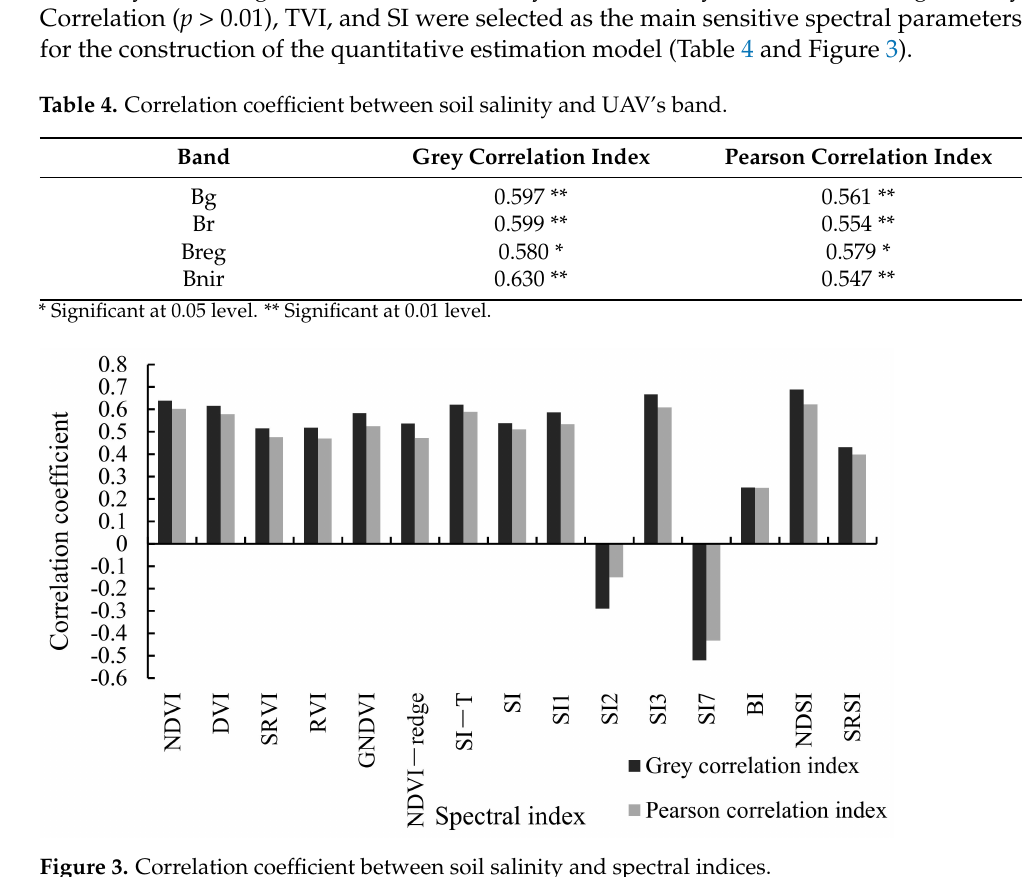
Figure 3. Correlation coefficient between soil salinity and spectral